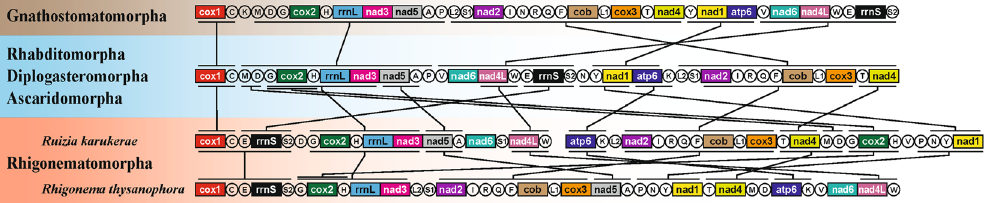
Figure 2. Linearized comparison of the mitochondrial gene arrangement of Ruizia karukerae and Rhigonema thysanophora (Rhigonematomorpha) and one species representative of Ascaridomorpha, Diplogasteromorpha, Gnathostomatomorpha and Rhabditomorpha, respectively. 22 tRNA genes are indicated by a single-letter abbreviation. The two leucine and two serine tRNA genes are marked according to their separate anticodon sequence, as L1 ( trnL1 -uag), L2 ( trnL2 -uaa), S1 ( trnS1 -ucu), and S2 ( trnS2 -uga). The non-coding regions are not